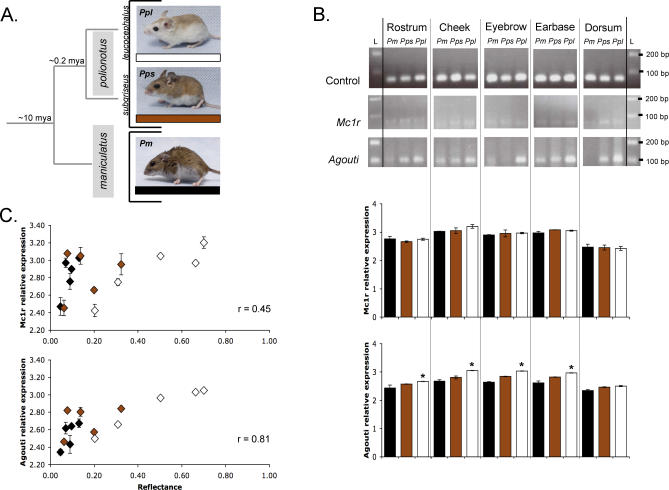
Gene Expression Assays for Mc1r and Agouti in Five Pigmentation Regions in Three Peromyscus Taxa(A) Phylogenetic relationship and approximate divergence times are shown for the P. polionotus subspecies and the sister species P. maniculatus. Photos show typical pigmentation pattern for each taxon. The phylogeny and pictures together highlight the similarity in pigmentation patterns between the mainland P. polionotus and P. maniculatus, the close evolutionary relationship between P. polionotus subspecies, and the derived nature of the beach mouse phenotype.(B) Qualitative (RT-PCR) and qPCR expression levels of Mc1r and Agouti mRNA relative to beta-Actin (control gene) for five distinct tissue samples in P. polionotus subspecies (P. p. leucocephalus [Ppl; white] and P. p. subgriseus [Pps; brown]) and P. maniculatus (Pm; black) are shown. A 100-bp ladder (L) flanks both sides of the RT-PCR gels. For the qPCR assays, since low Ct values indicate high expression level, we transformed the raw expression data to be more intuitive: relative expression values represent the averaged Ct values for each species subtracted from the sum of expression values across all species. Significant differences in relative expression levels between P. polionotus subspecies are indicated by asterisks (Student's t-test, p < 0.05). Bars indicate the standard error for each assay.(C) Association between level of Mc1r and Agouti relative expression and pigmentation (measured by reflectance) is shown among the three taxa. Correlation (r) values are shown.